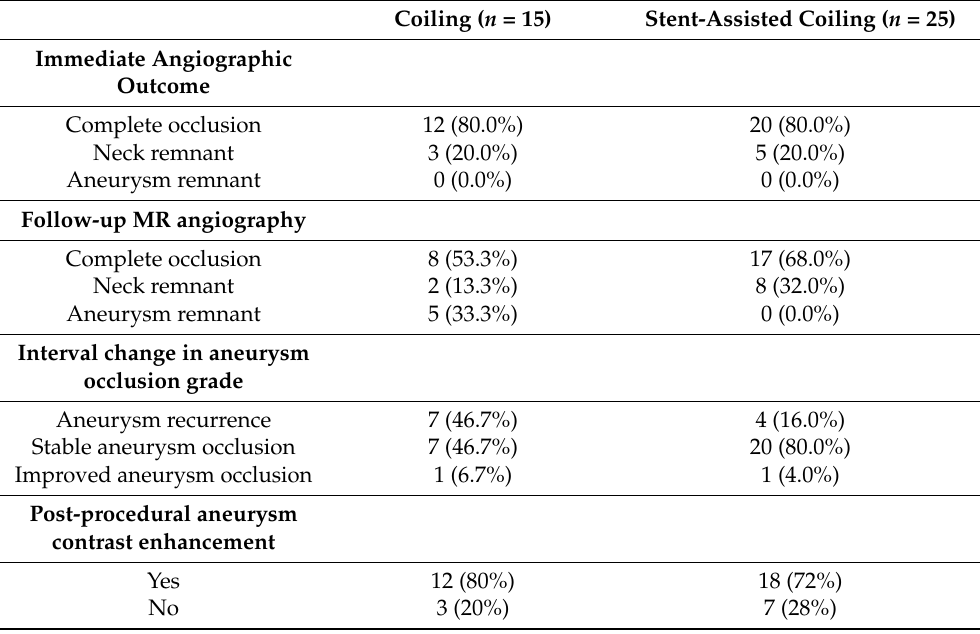
Table 2. Comparison of aneurysms treated with coiling alone vs. stent-assisted